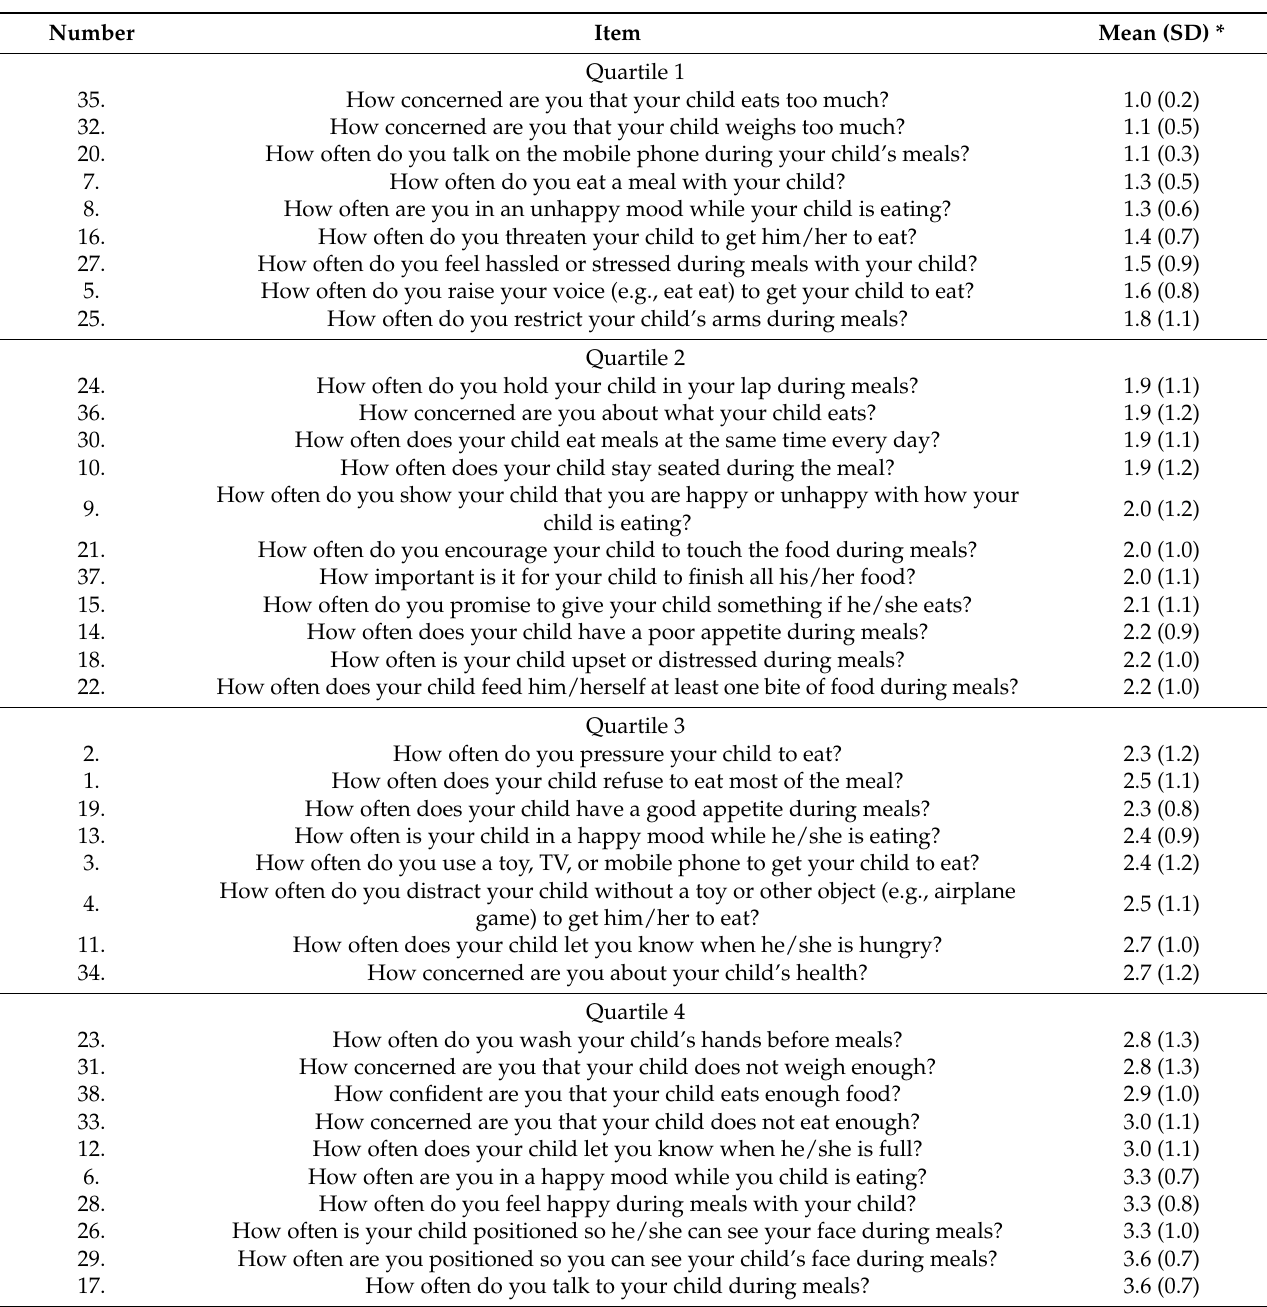
Table 2. Items, Mean Scores, and Quartiles in the Responsive Feeding